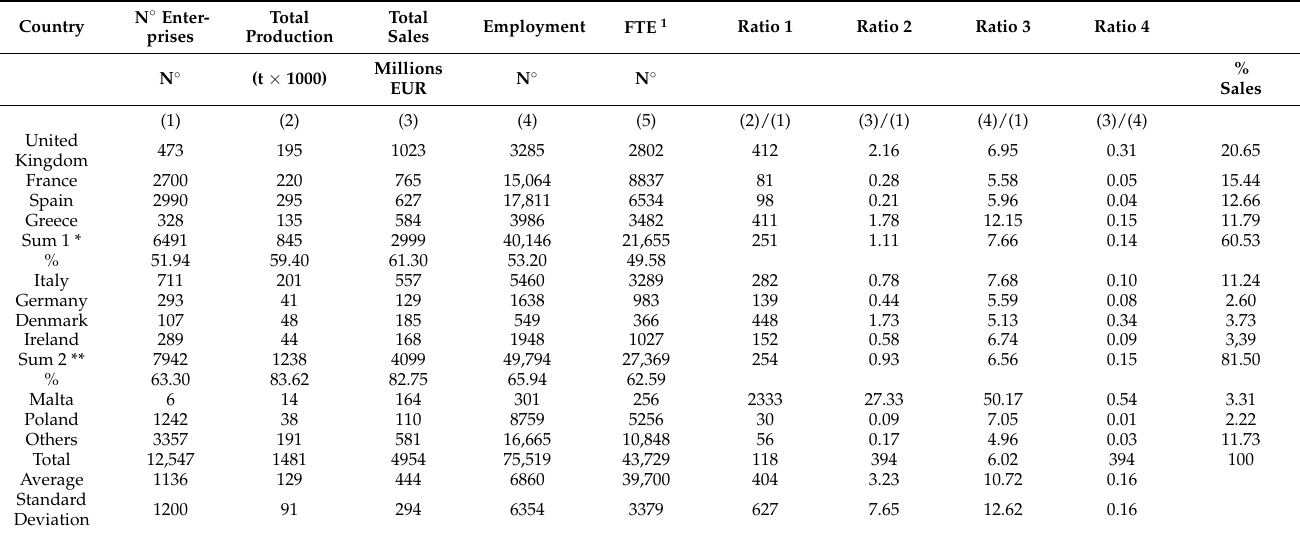
Table 10. Structural indicators of the aquaculture industry in the EU and ratio analysis.